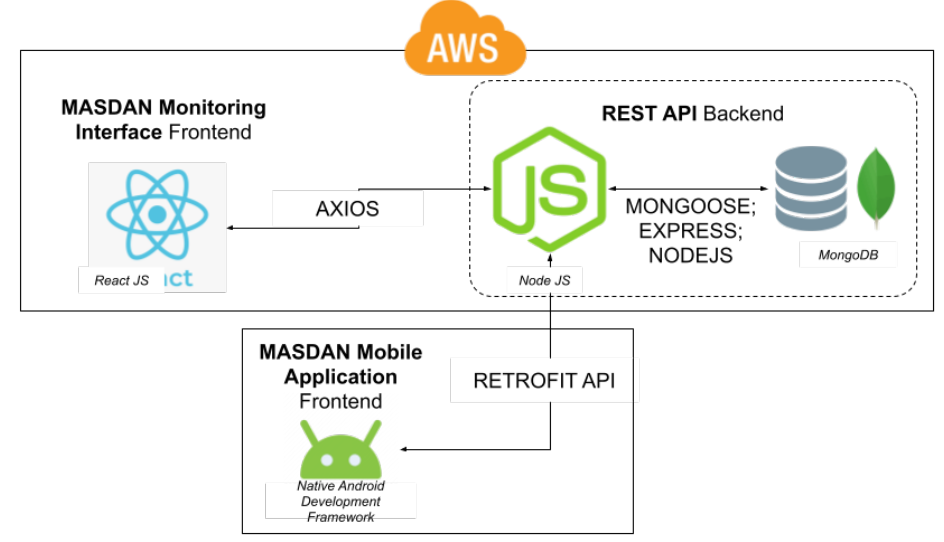
Figure 2. MASDAN Digital System